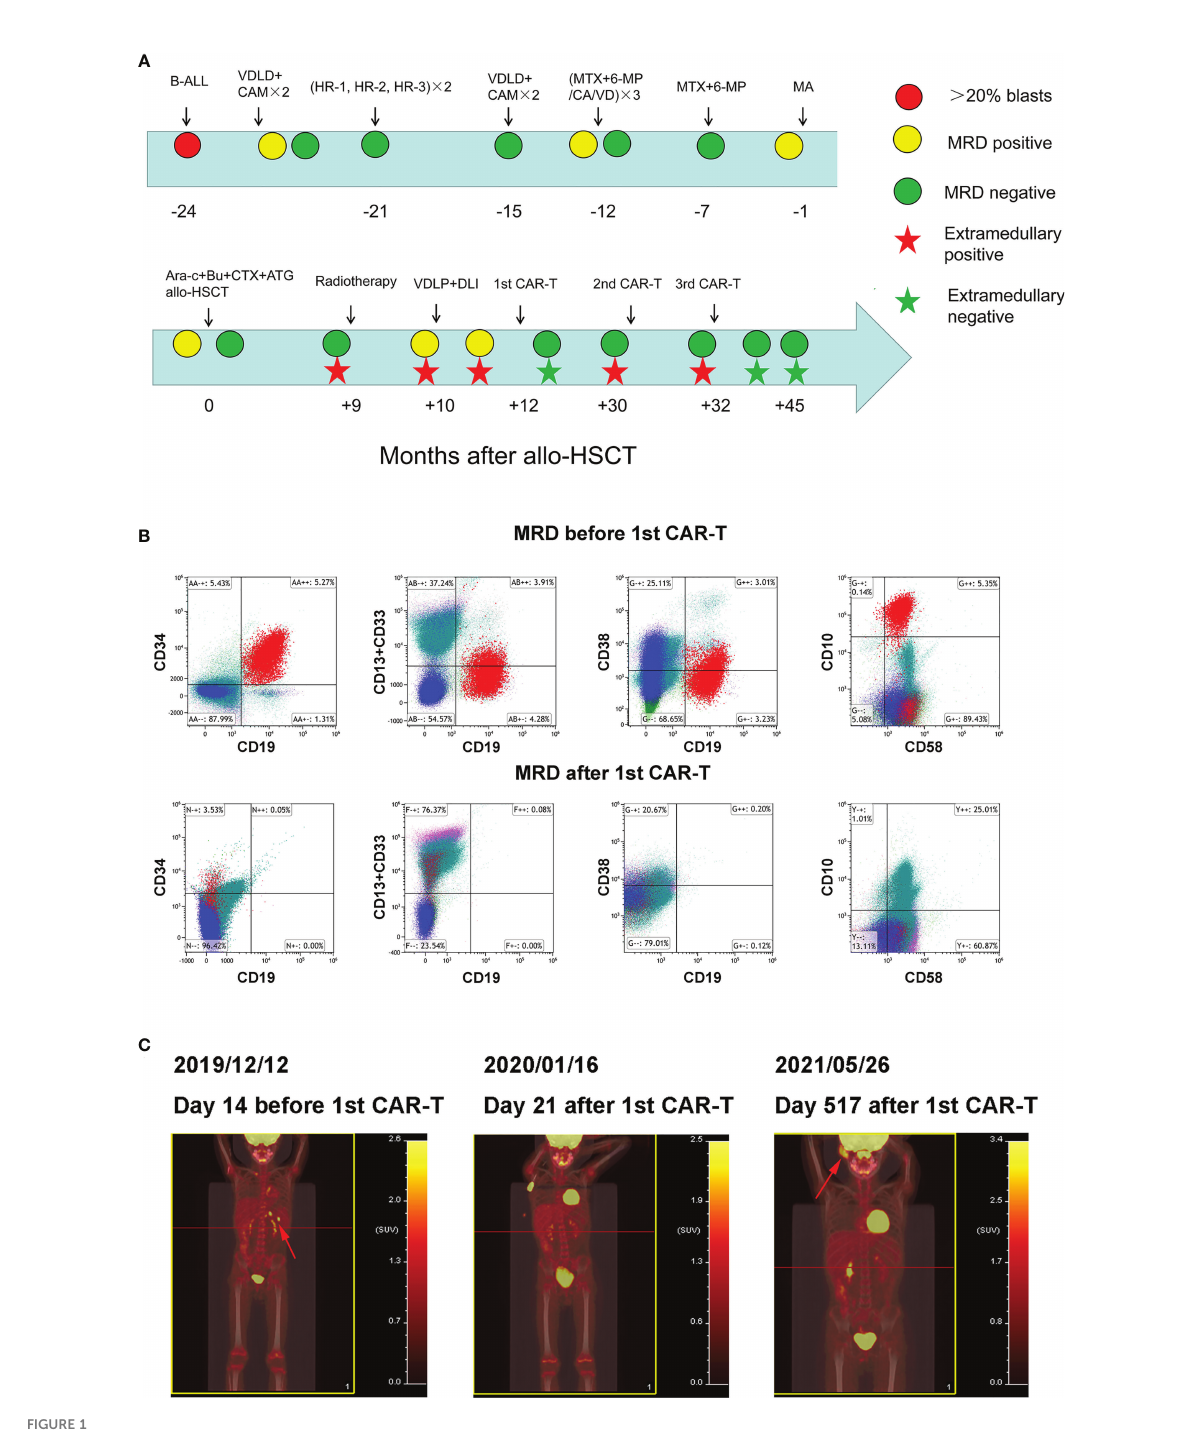
FIGURE 1 Clinical treatment process and the response of the patient (A) Clinical treatment process and response of the patient. (B) Bone marrow MRD before and after 1 st CAR-T treatment. (C) Whole body PET/CT before and after 1 st CAR-T